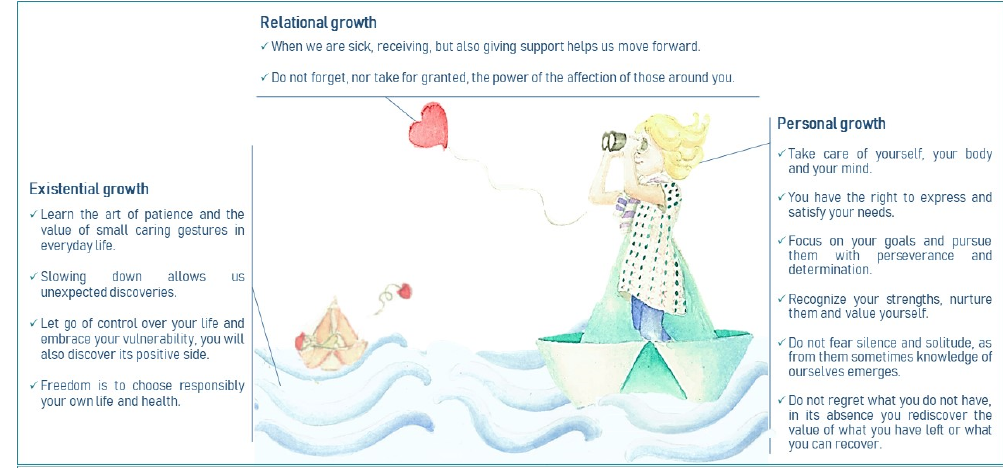
Figure 2. Results on benefit finding translated into tips for patients.